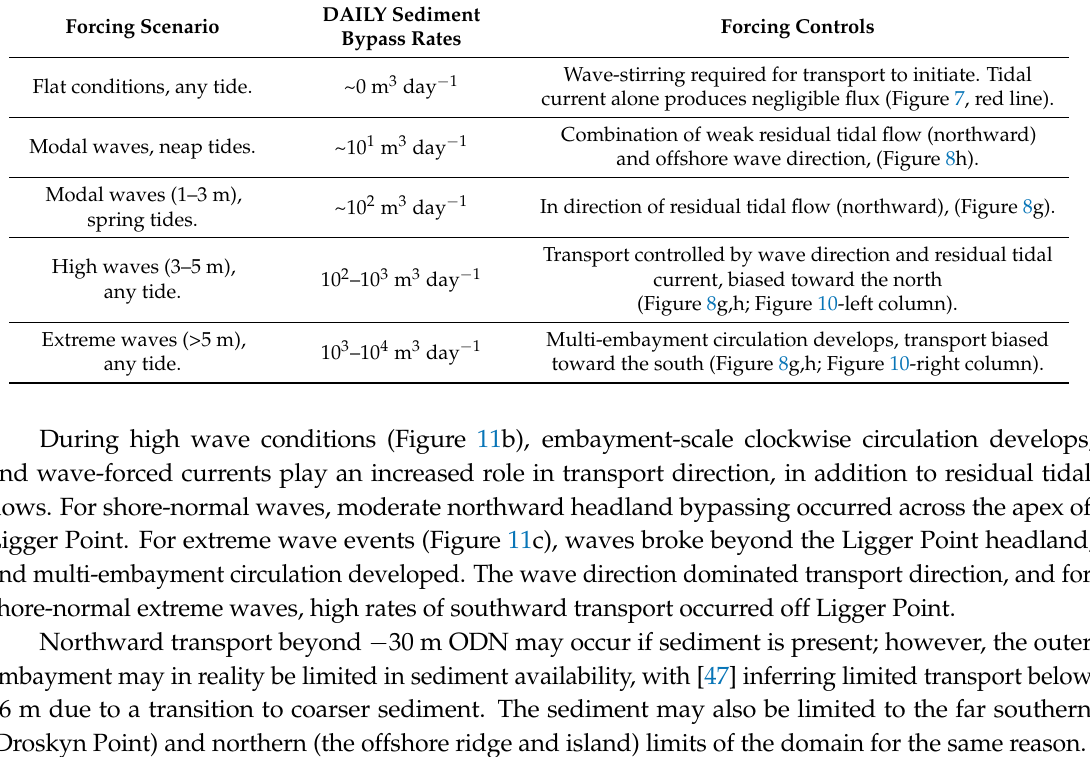
Table 4. Headland bypassing rates for the observed headland under various forcing. DAILY Sediment Forcing Scenario Bypass Rates